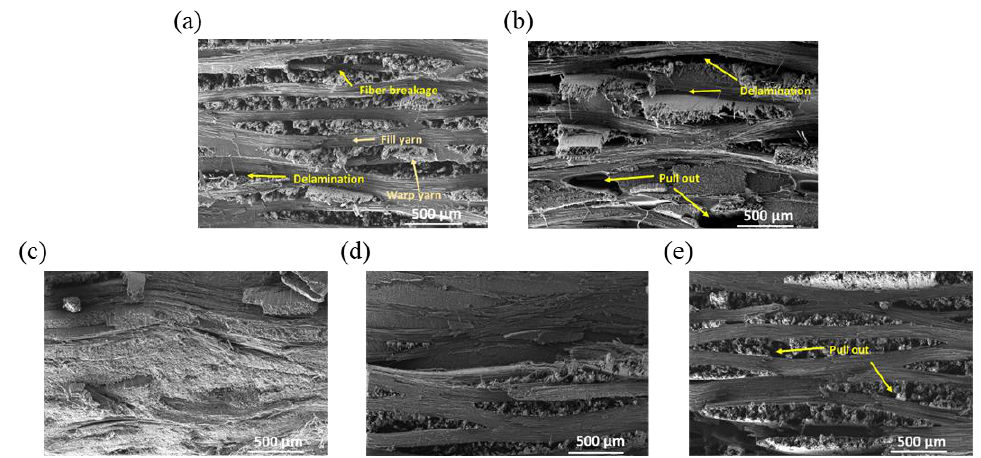
Figure 12. FE−SEM images of fracture surfaces on composites reinforced with ( a ) C−CFs and ( b ) de−CFs, as well as ( c ) PI 0.5 wt%, ( d ) PI 1.0 wt%, and ( e ) PI 1.5 wt% of the PI−sized CFs.